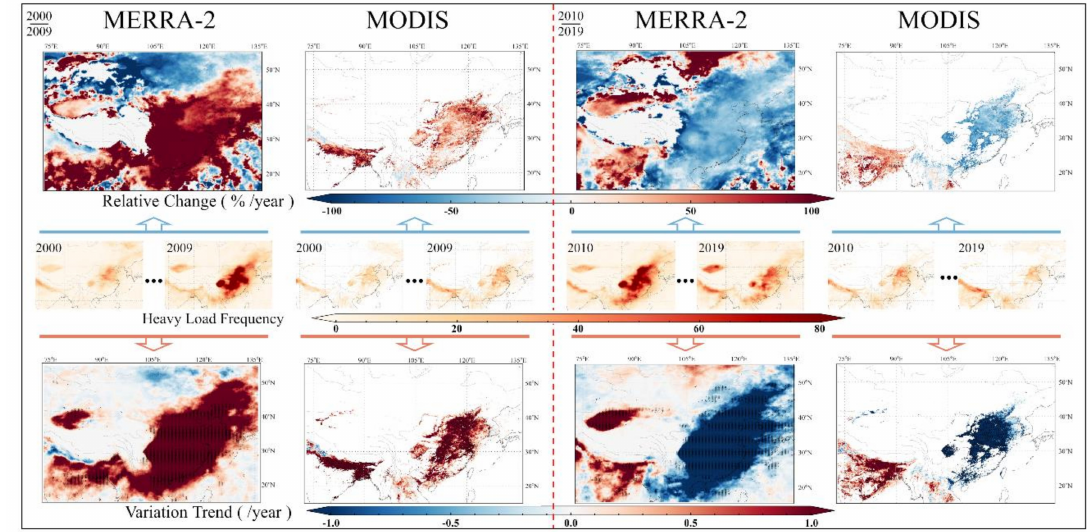
Figure 6. Relative change and variation trend of annual frequency of heavy aerosol load using MERRA-2 and MODIS dataset during 2000–2019 (small black dot on the variation trend map denotes p <